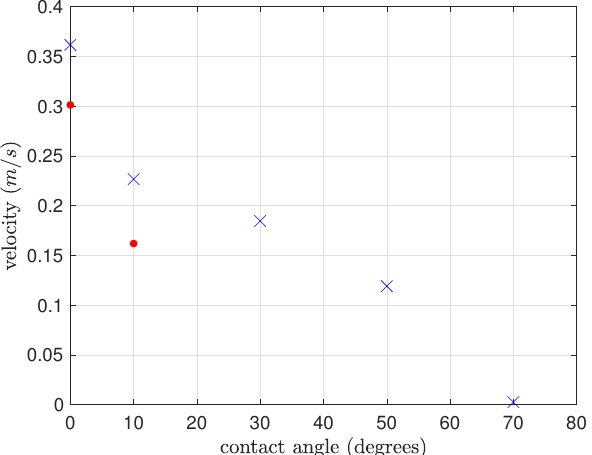
Figure 14. Average velocity of the front as a function of the static contact angle θ . Blue crosses indicate front velocity in the + x direction while red dots indicate the front velocity − x . Beyond θ ≥ 30° the front in the − x direction is pinned and then velocity is not indicated. The geometry corresponds to the smallest pattern A of Figure